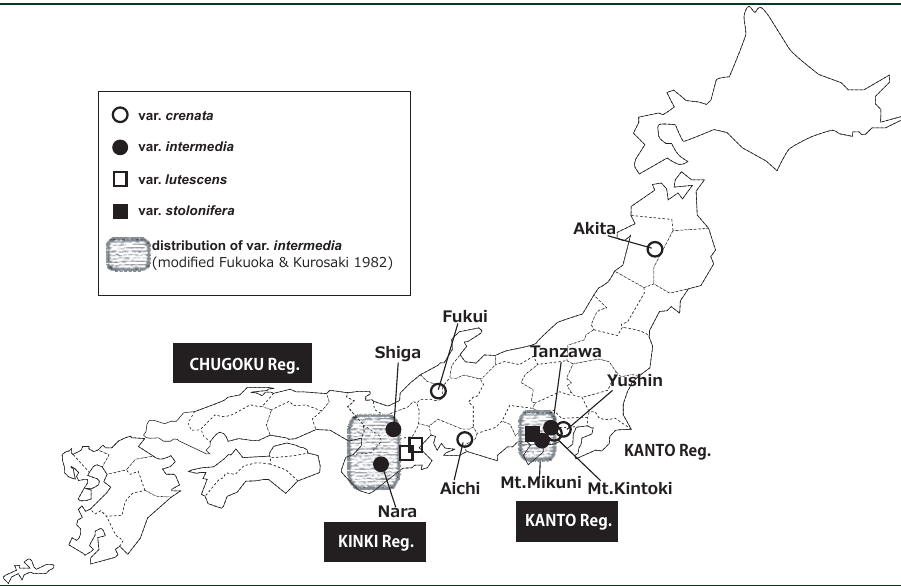
Figure 1. Map of Japan shows the sites where Salvia lutescens taxa were sampled. Open circle = var. crenata , filled circle = var. intermedia , open square = var. lutescens , filled square = var. stolonifera . The areas encircled with dotted lines show the Kinki and Kanto regions, as